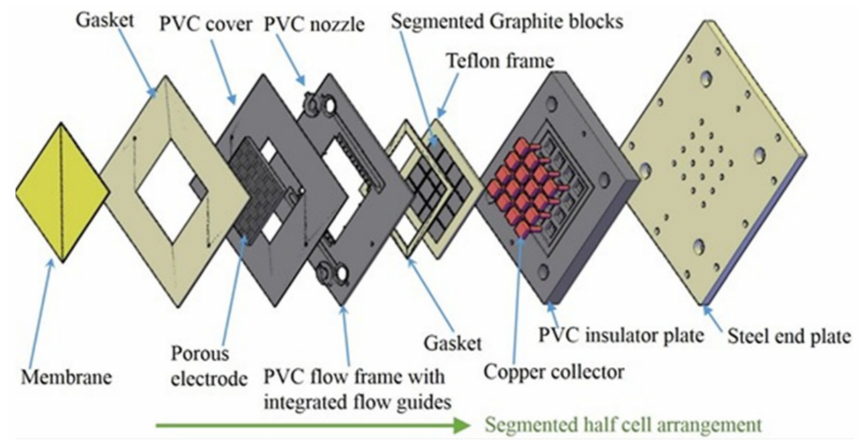
Figure 10. Exploded view of half-cell components at the segmented side (reproduced from ref [101], with permission from Elsevier).